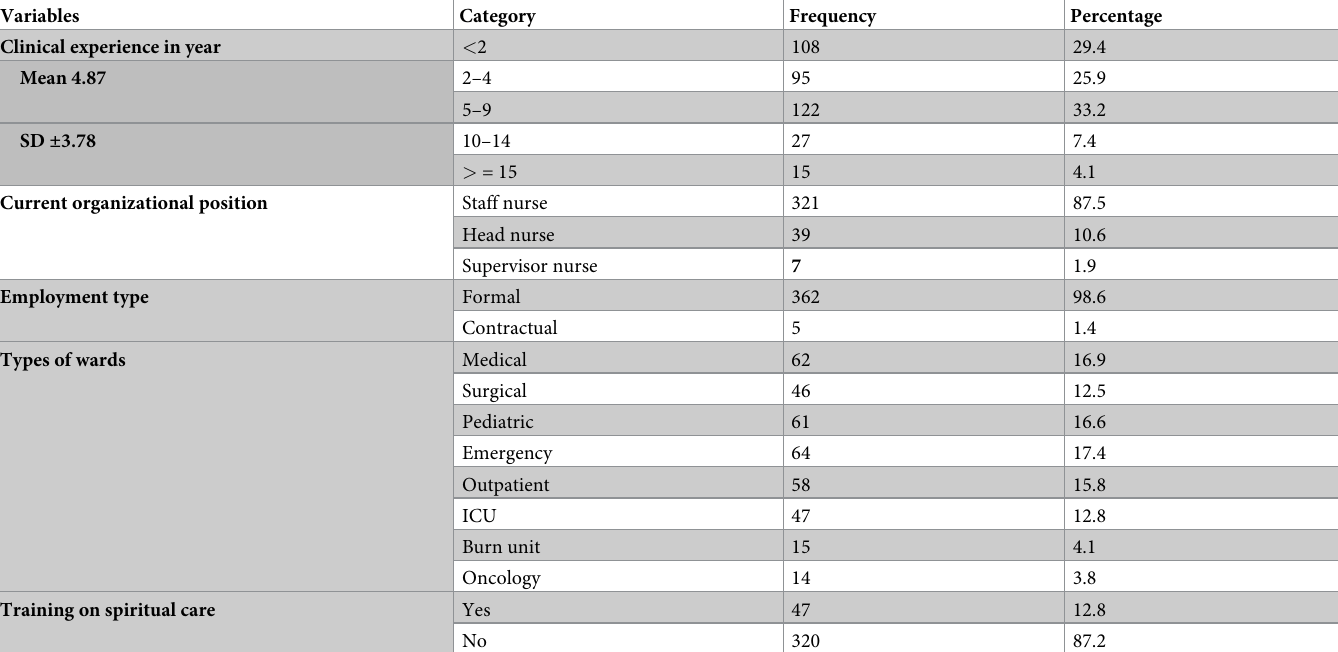
Table 2. Nurses’ work-related characteristics in selected public hospitals in southwest Ethiopia in 2021 (n = 367). Variables